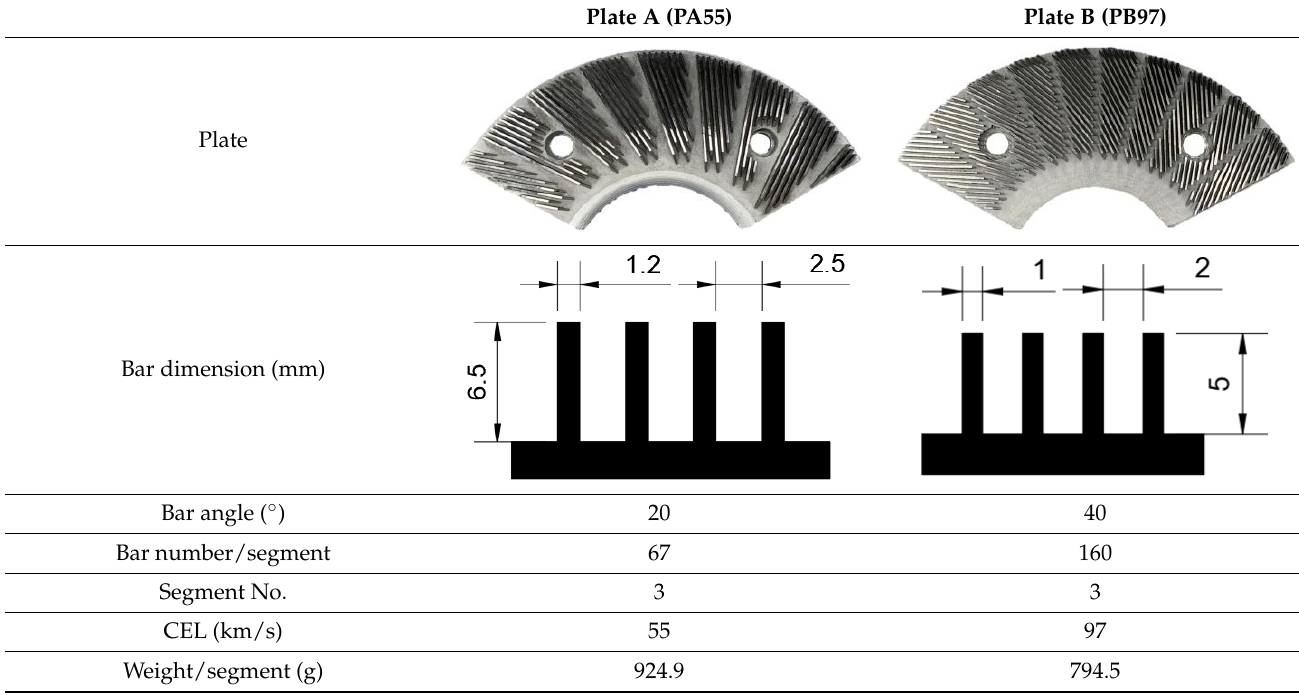
Table 2. Comparison of the refiner plates with different bar fillings.